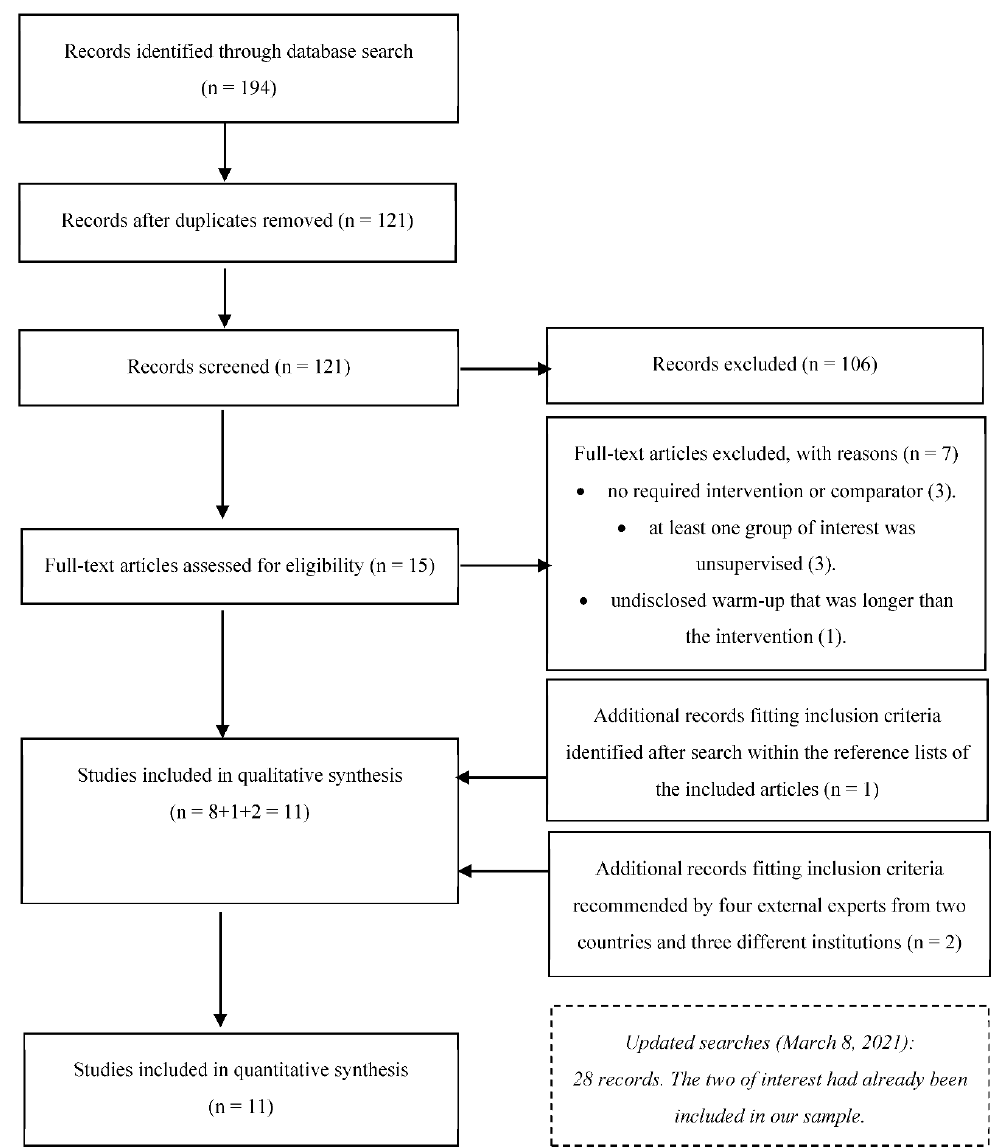
Figure 1. Flowchart describing the study selection process.